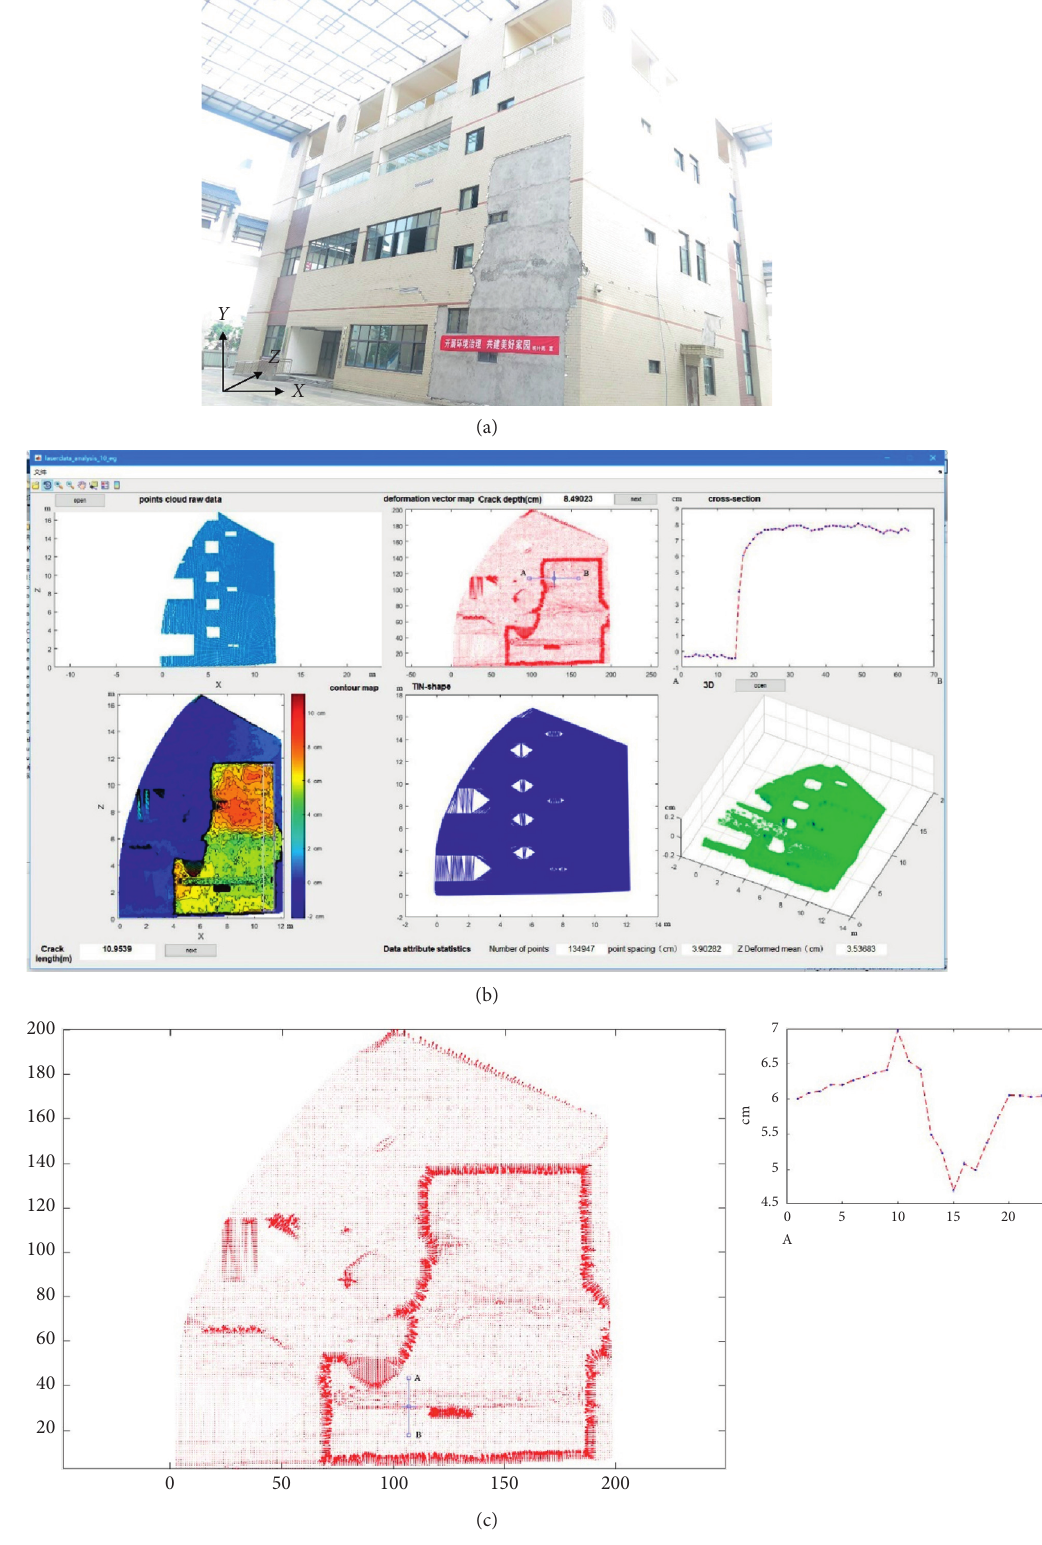
Figure 12: (a) Frame building. (b) Frame structure information extraction. (c) Banner-to-wall